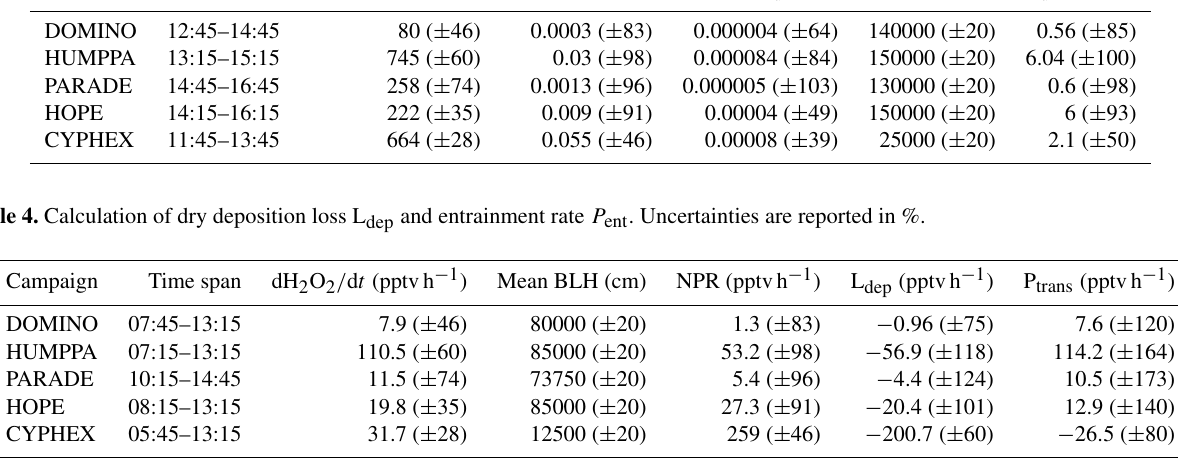
Table 3. Calculation of daytime dry deposition loss rate k d and the deposition velocity v d . Uncertainties are reported in %. Campaign